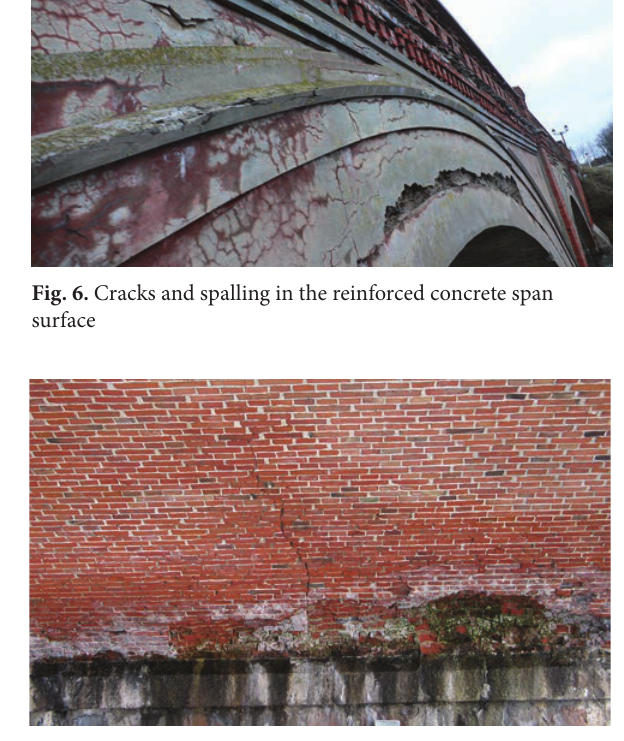
Fig. 7. A crack and falling out bricks around the water drainage pipes on pier